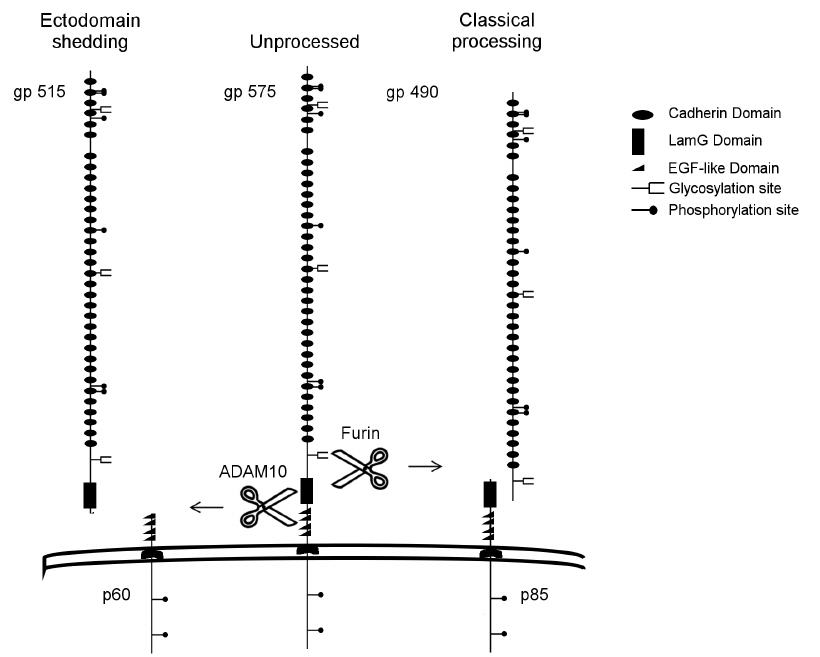
Figure 8. Alternative Fat1 processing in pancreatic cancer cells. Full-length Fat1 can be expressed on the cell surface; alternatively, the full length protein can be cut by a furin-type protease to yield the membrane-integrated heterodimer as described by Sadeqzadeh et al. and designated as ‘‘classical processing’’. Another alternative is ectodomain shedding as described in this work, where the full-length protein is cut by ADAM10 into a p60 C-terminal remnant fragment (which may be further processed) and a gp515 soluble form released into the